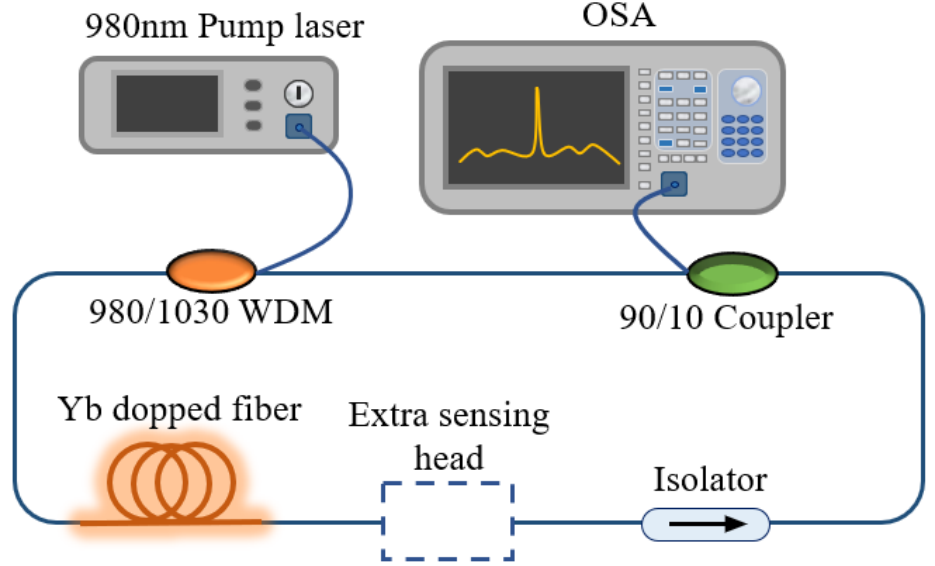
Figure 4. Traditional FRL sensing structure logic framework.